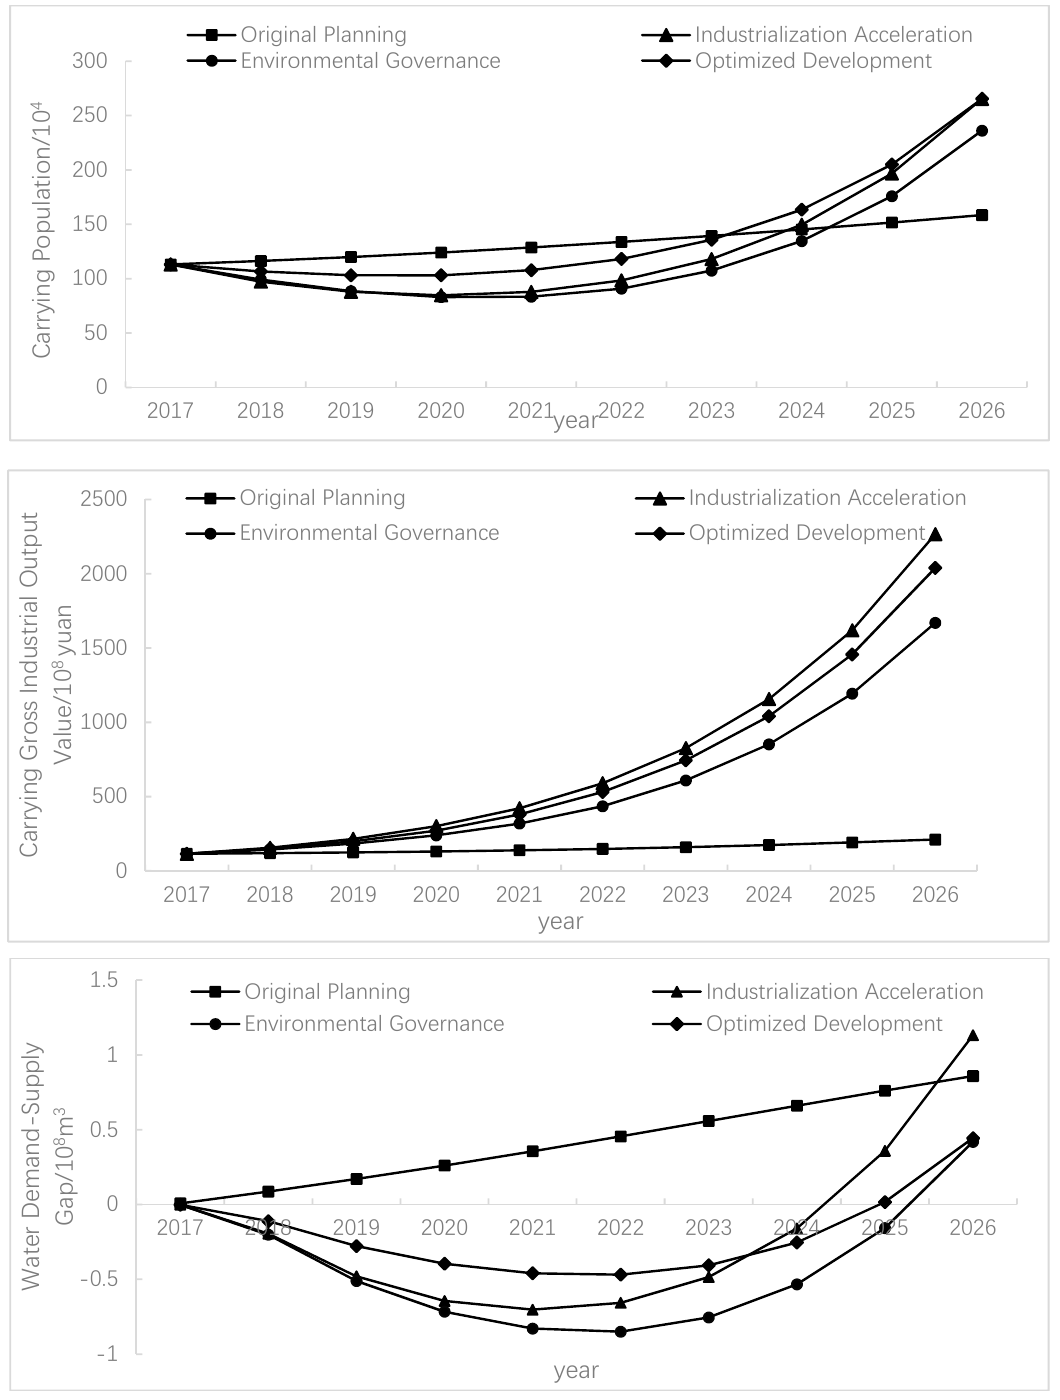
Figure 4. The dynamics of the simulated water resources carrying capacity in the four scenarios in Xiong’an New Area.